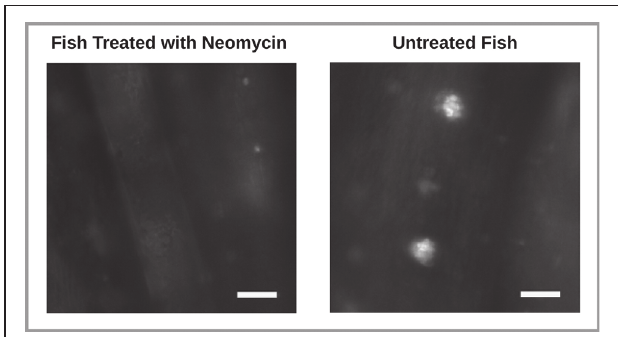
FIGURE 3 | Wide-field fluorescence images of two zebrafish tail fins . Stained neuromast hair cells are absent in the Neomycin treated fish (left) and present in the untreated fish (right). Scale bar represents 75 µ m.